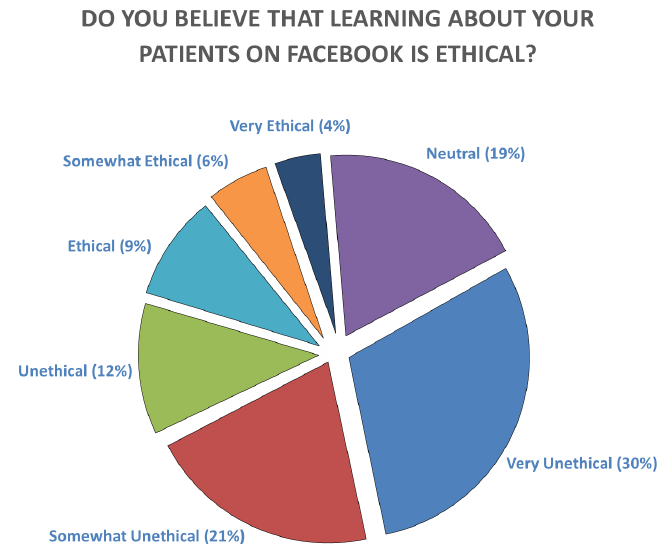
Figure. Responses to survey question about ethics of searching for patients online.